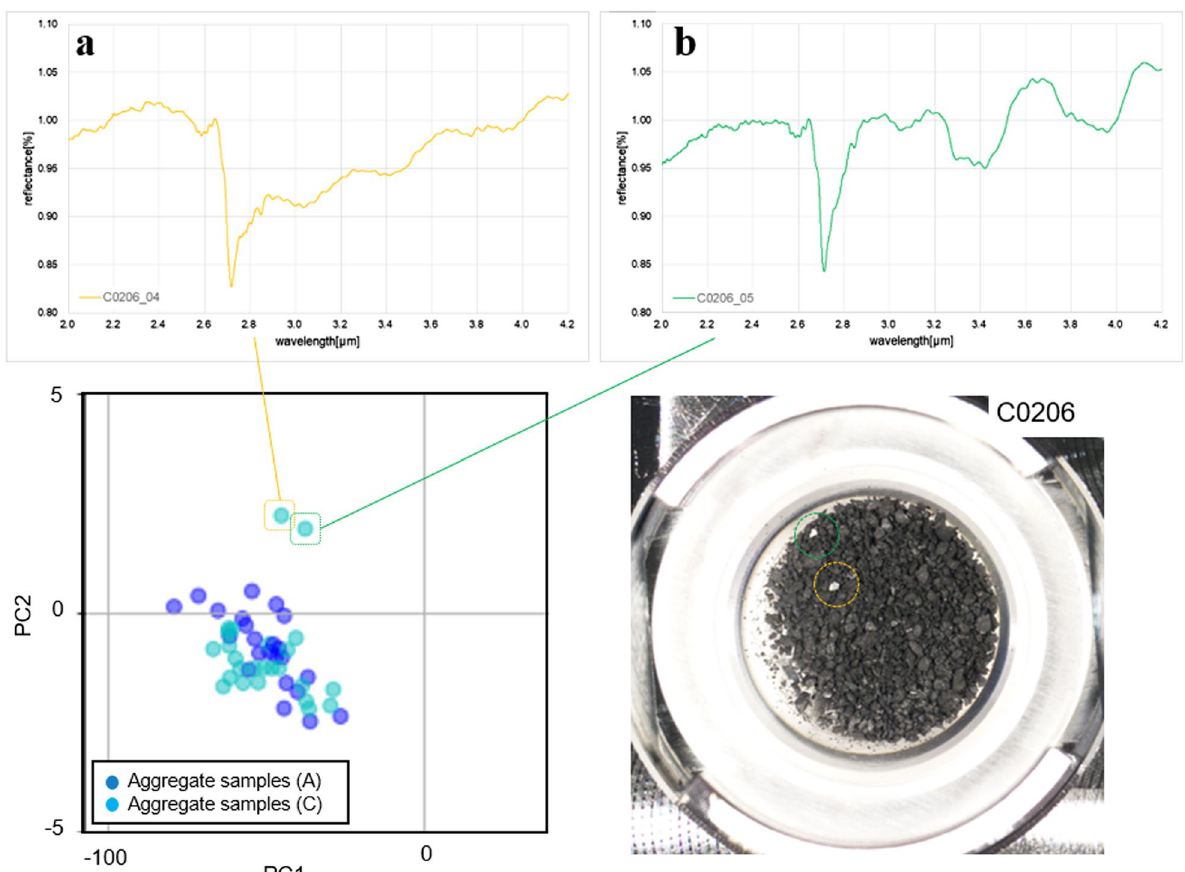
Fig. 12 Rarely detected unique spectra in aggregate samples: a carbonate in aggregate sample, C0206, b hydroxyl component with broad OH absorption in aggregate sample, C0206. The enclosed areas in the optical microscope images indicate the beam